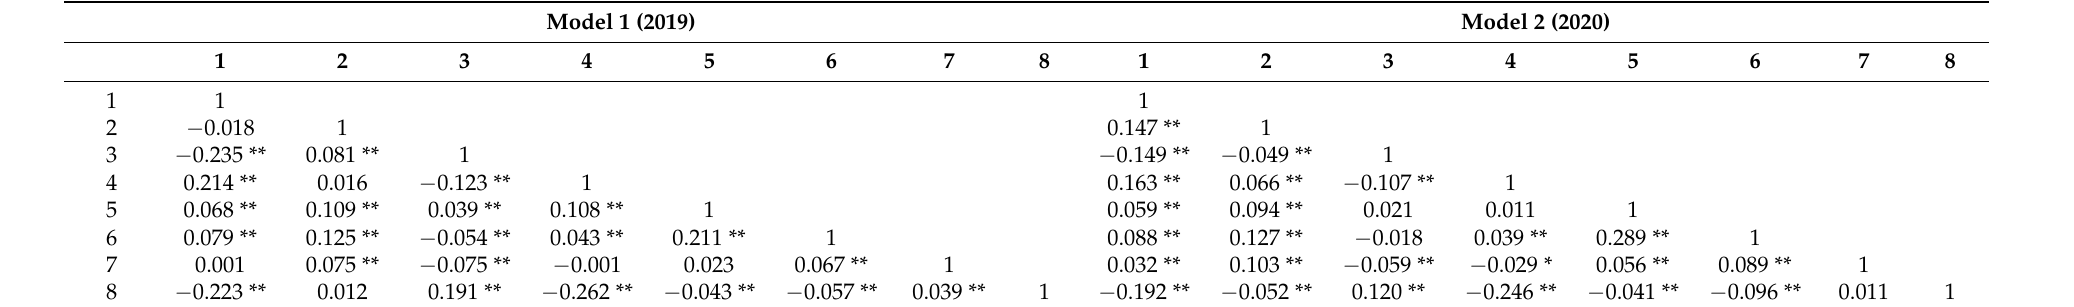
Table 5. Bivariate relationships between